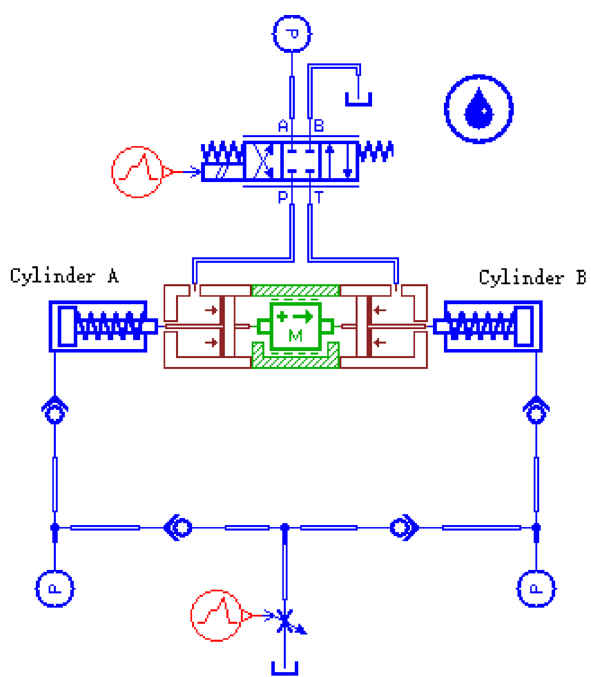
Fig. 12 Simulation model